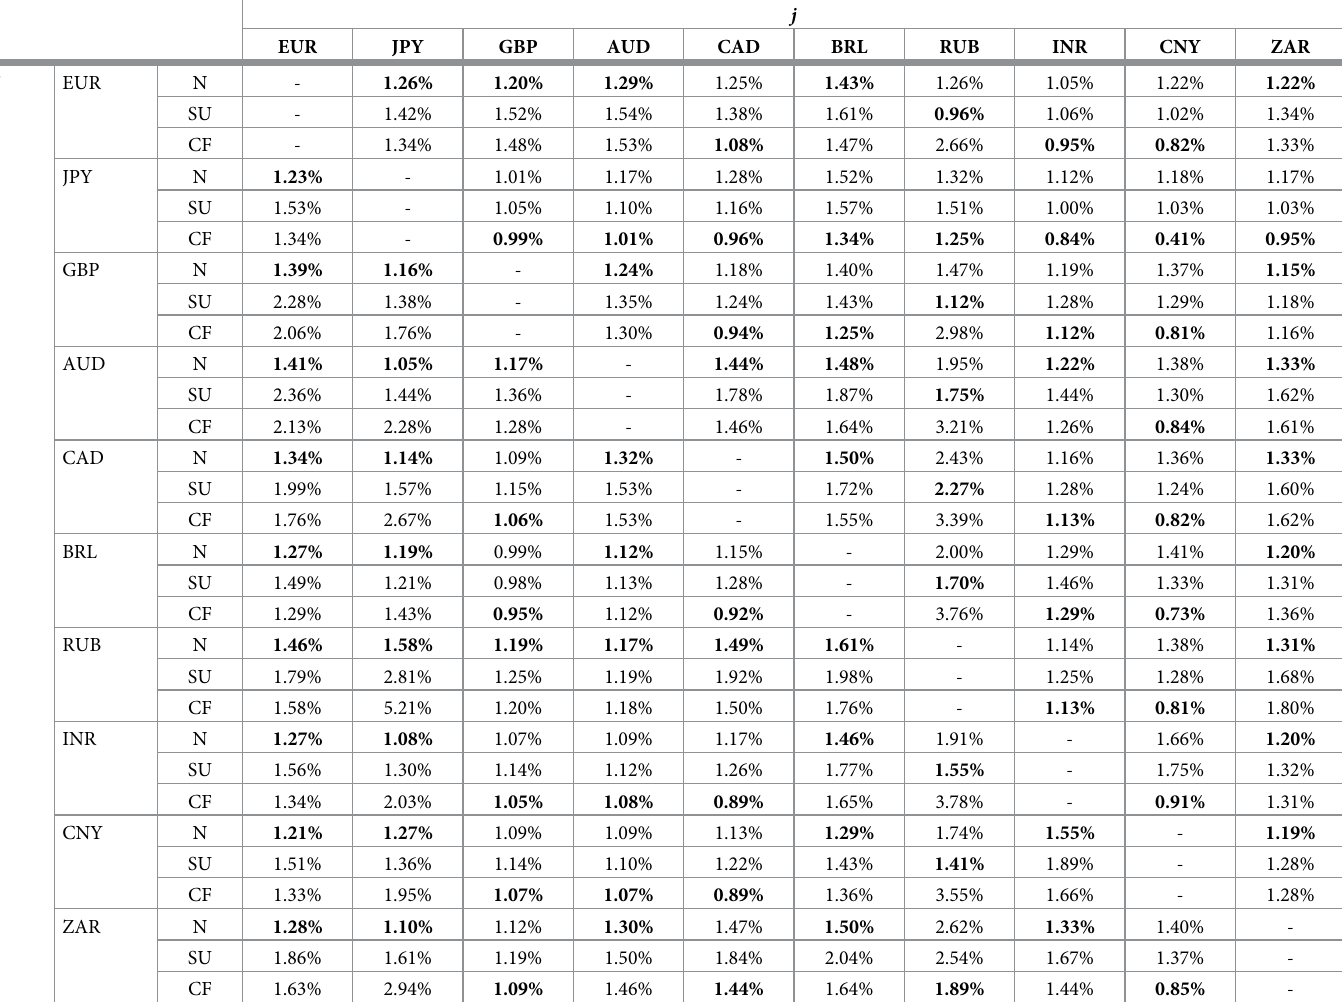
of the forecasted CoVaR 5 % j j i